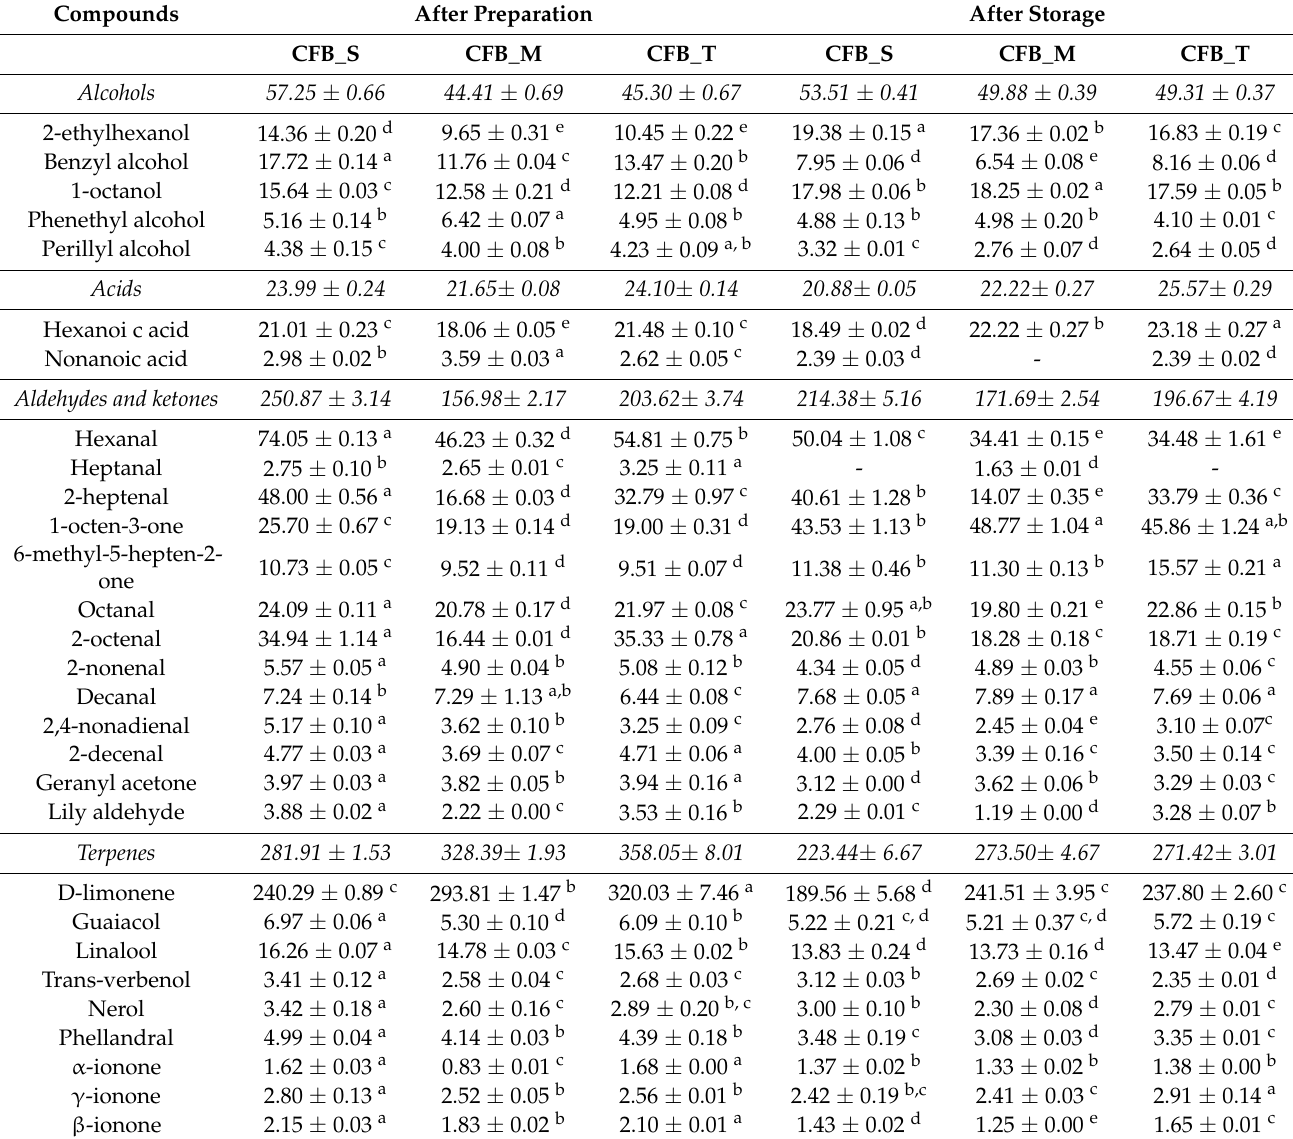
Table 6. Volatile compounds ( µ g/kg) of blackberry juice/blackberry cream fillings with after preparation and after storage.